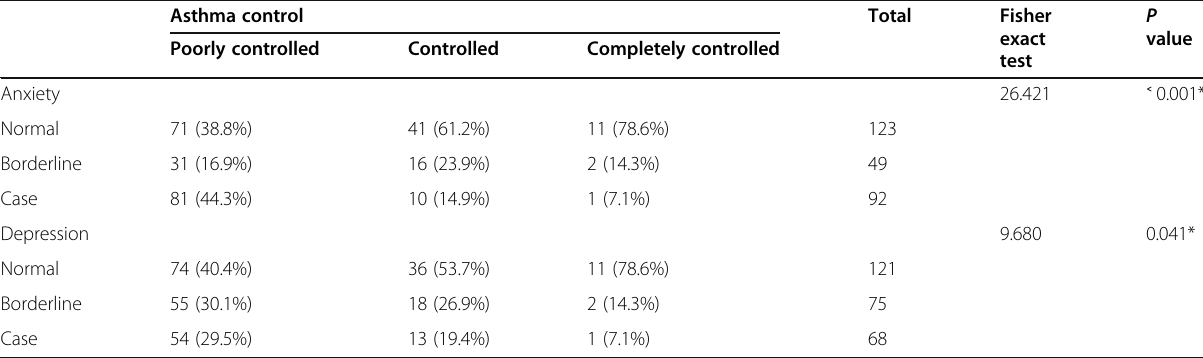
Table 4 Association between ACT and HADS